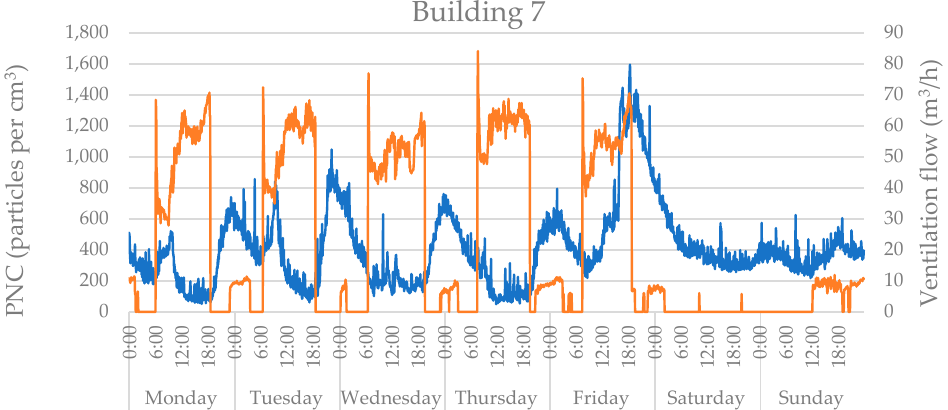
Figure 7. The NP number concentration (blue line) and the ventilation flow (orange line) in Building 7 during the heating season. The NP concentrations and the ventilation flow were measured in five-minute intervals.